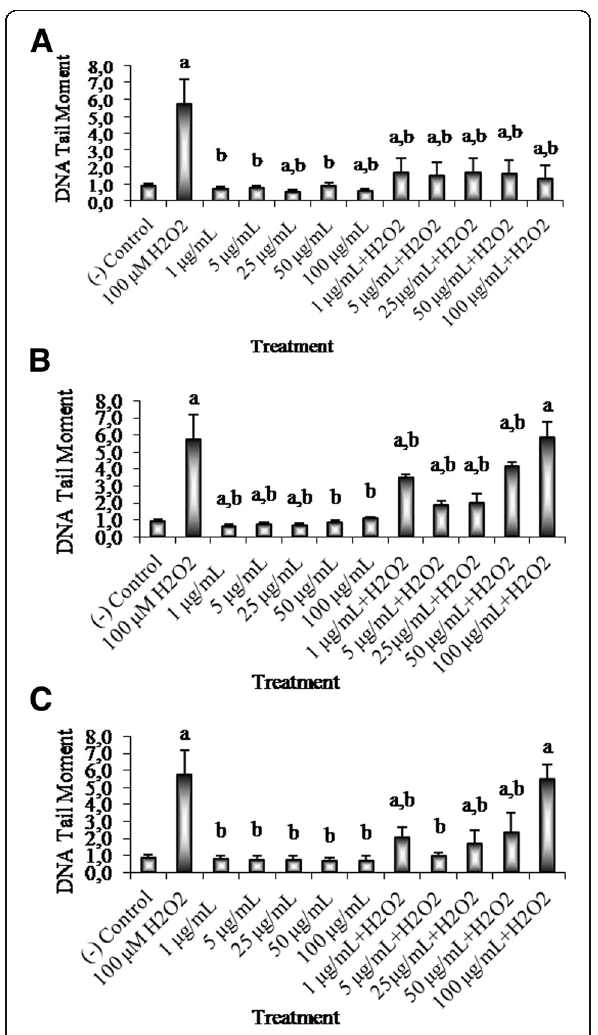
Fig. 4 Gentoxicity/antigenotoxicity of (+/ − ) catechins ( a ), gallocatechin ( b ), and rutin ( c ). DNA damage was expressed as DNA tail moment. a p < 0.05, compared with negative control (0.5% DMSO); b p < 0.05, compared with 100 μ M H 2 O 2 (positive control)